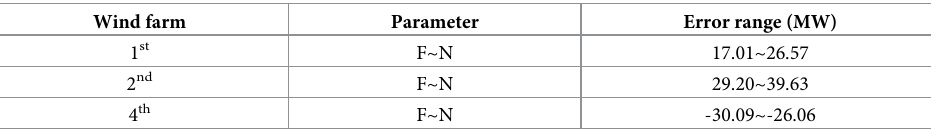
Table 4. The power prediction errors distribution’s